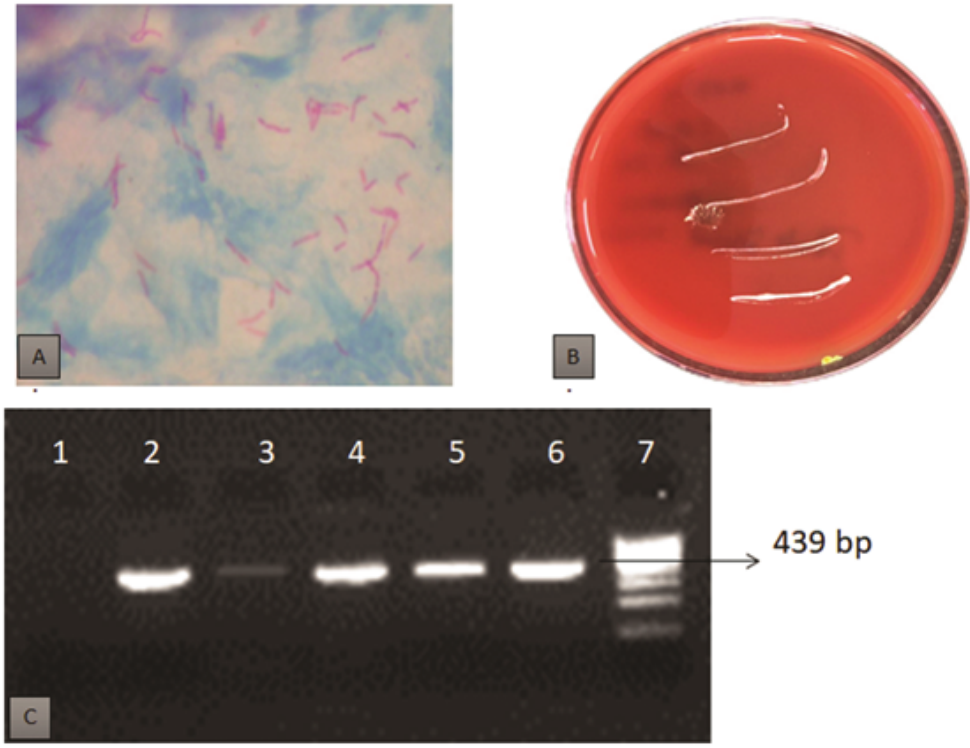
Figure 3. (A) Ziehl Neelsen-stained corneal scrapings showing acid-fast bacilli against a blue background. (B) White colored, opaque, non-hemolytic colonies of NTM on blood agar. (C) Amplification of a 439 bp-specific DNA fragment of the hsp 65 region of mycobacterial DNA. Lane 1: Negative control; Lane 2–5: Amplified mycobacterial DNA (439 bp); Lane 6: Positive control; and Lane 7: Molecular weight marker (100 bp).